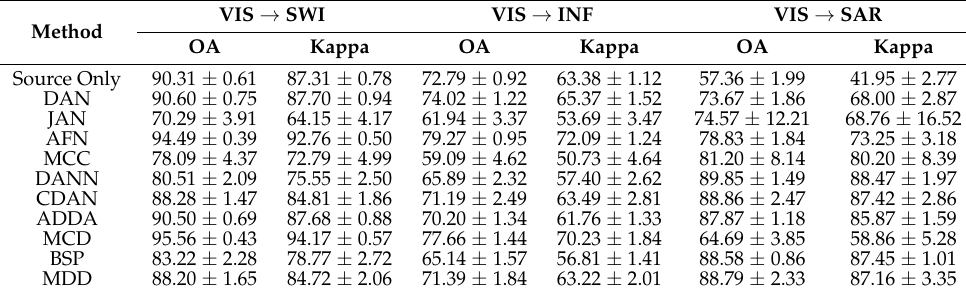
Table 3. Classification